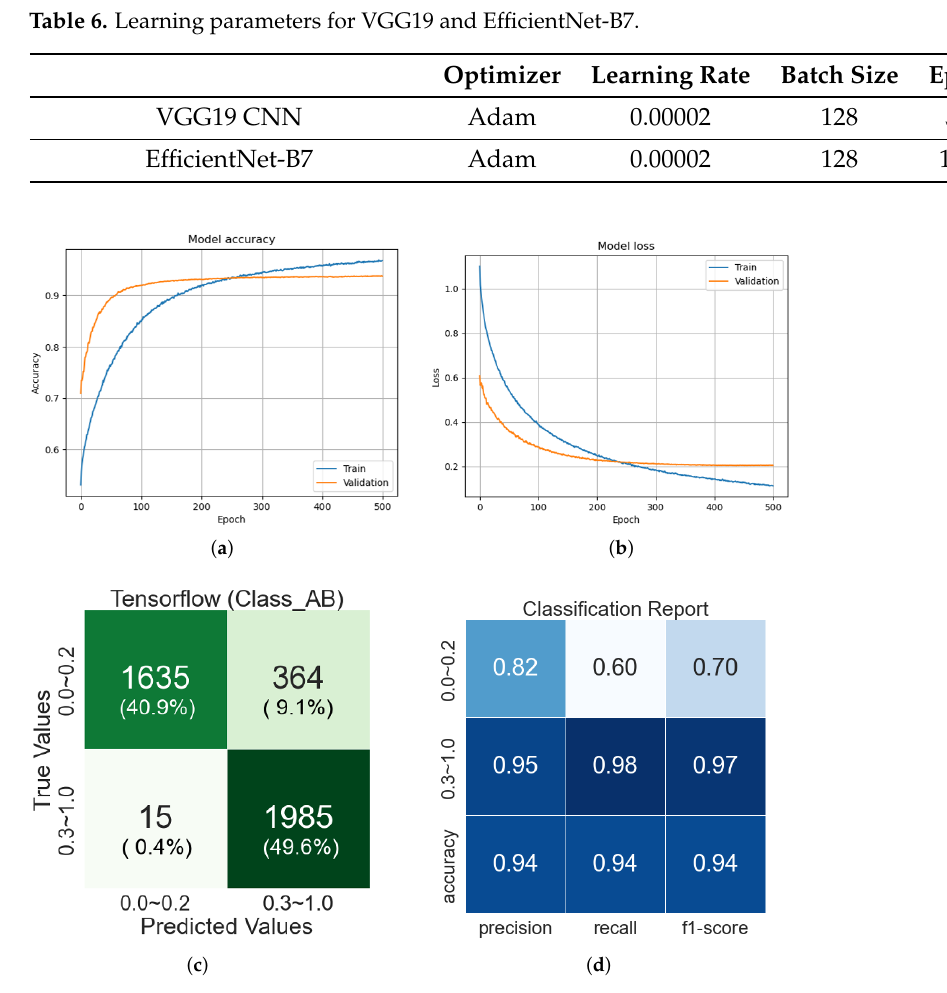
Figure 7. Training results of VGG19-based CNN for Step-1. ( a ) Accuracy; ( b ) Loss; ( c ) Confusion matrix; ( d ) Classification